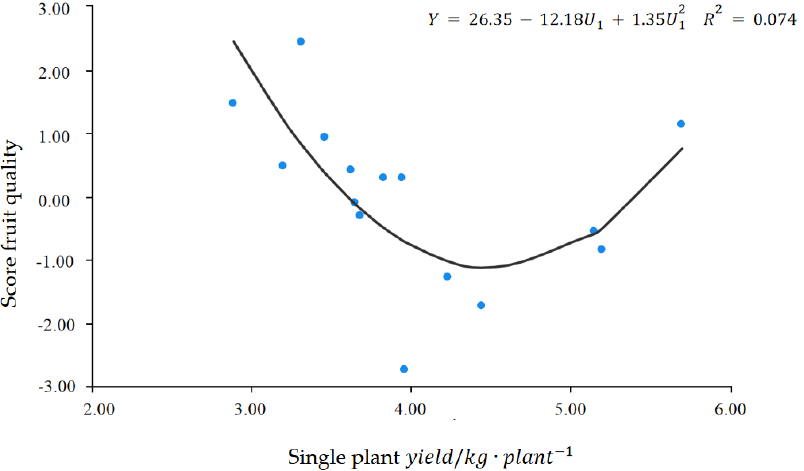
Figure 8. Quadratic regression curve of quality compressive score and yield. The blue dots represent the final evaluation including quality scores and yields for all treatments.